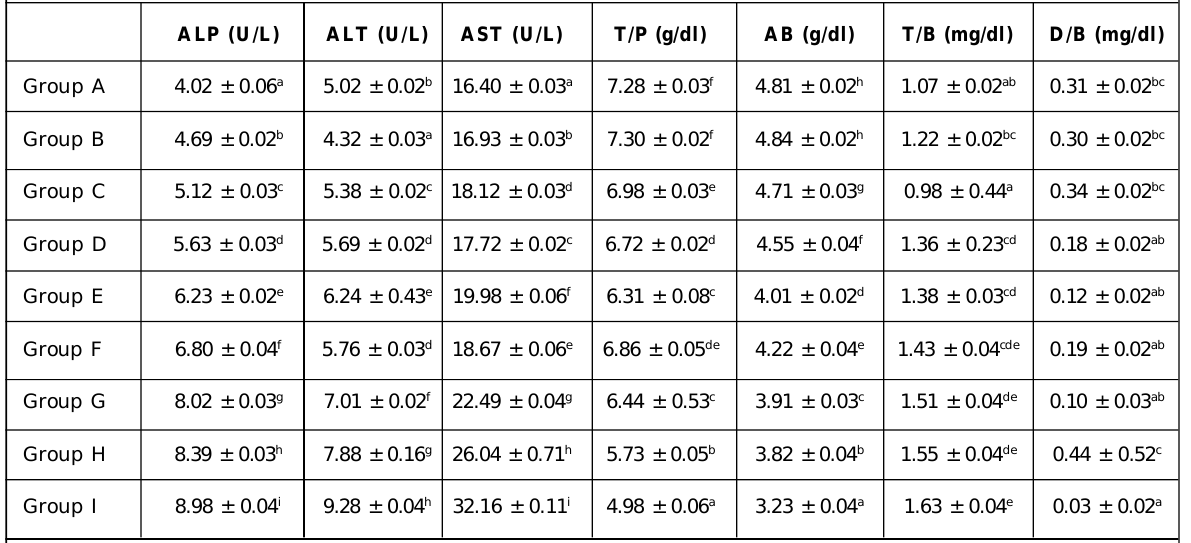
Table 1: Liver integrity assessment of male albino rats